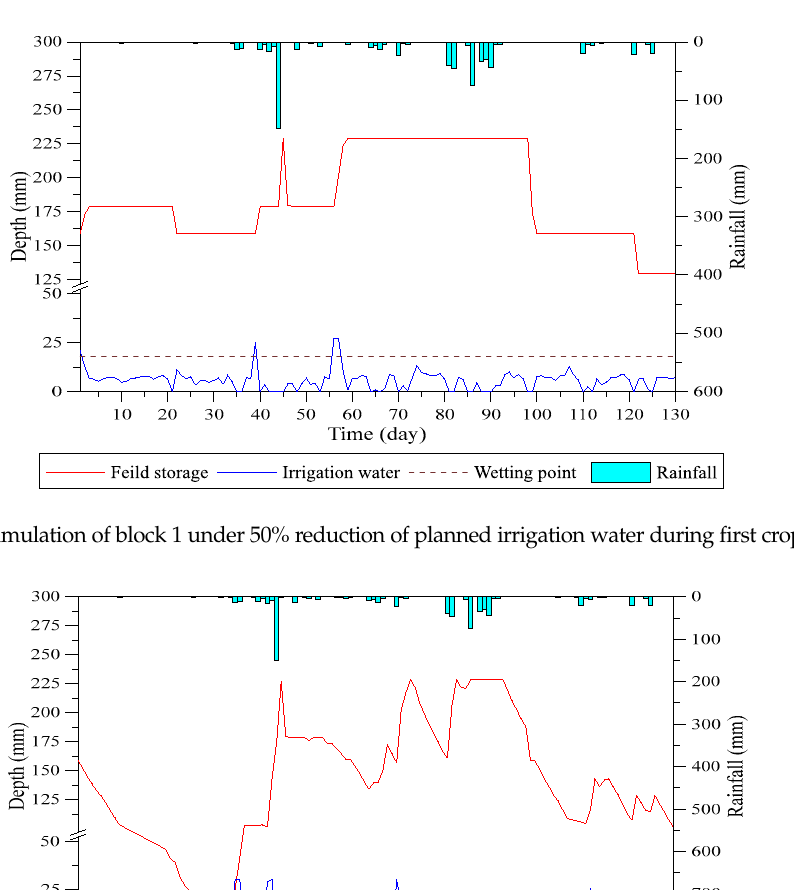
Figure 23. Simulation of block 3 under 50% reduction of planned irrigation water during first crop season.